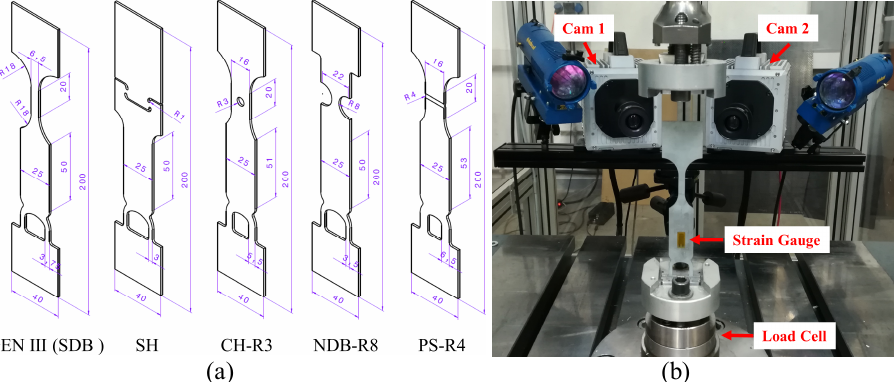
Fig. 1. (a) Overview of the geometry of plasticity and fracture specimens (mm); (b) Experimental setup with servo-hydraulic machine and high-speed cameras.